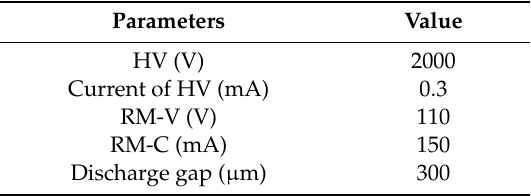
Table 2. HV- µ EAM parameters.